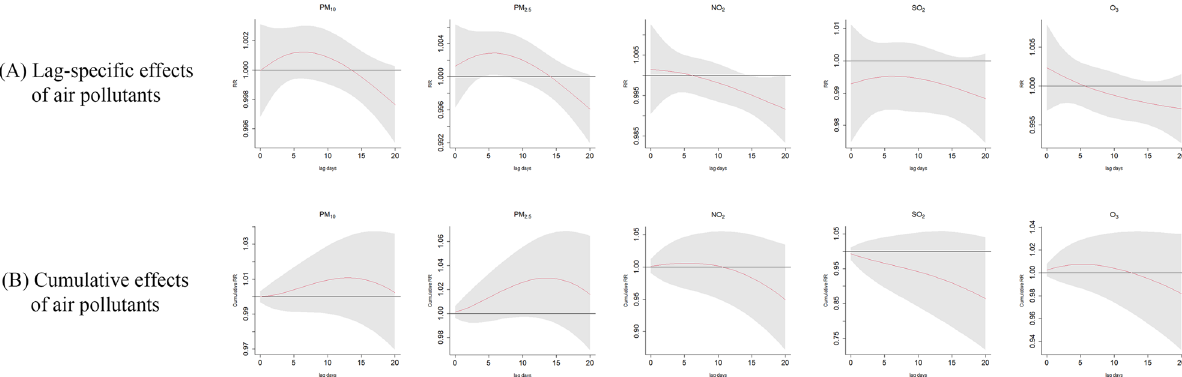
Figure 2. (A) Lag-specific RRs and (B) cumulative RRs in adult varicella cases per 10-unit increase in daily mean concentrations of air pollutants in the single-pollutant model; PM 10 , particles with aerodynamic diameter less than 10 μm; PM 2.5 particles with aerodynamic diameter less than 2.5 μm, NO 2 nitrogen dioxide, SO 2 sulfur dioxide, O 3 maximum 8-h moving average ozone